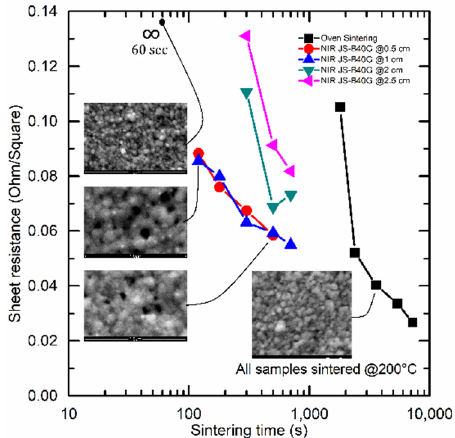
Figure 2. Sintering duration of near-infrared continuous sintering (blue-red-green-purple) and oven sintering (black) of JS-B40G ink. Switching from thermal to near-infrared sintering drastically reduces the sintering time, even with a non-optimized ink. Every scanning electron microscopy (SEM) image has a 1 µm field of view in horizontal direction, and shows the progression of particle growth from the early stage of sintering up to the final conductive layer.